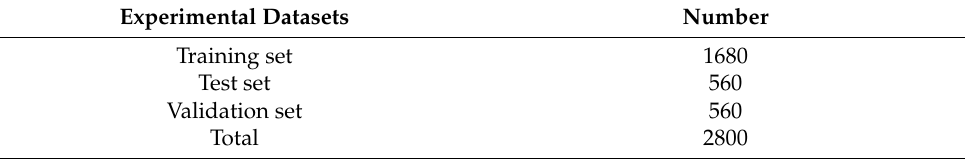
Table 1. Distribution of datasets.